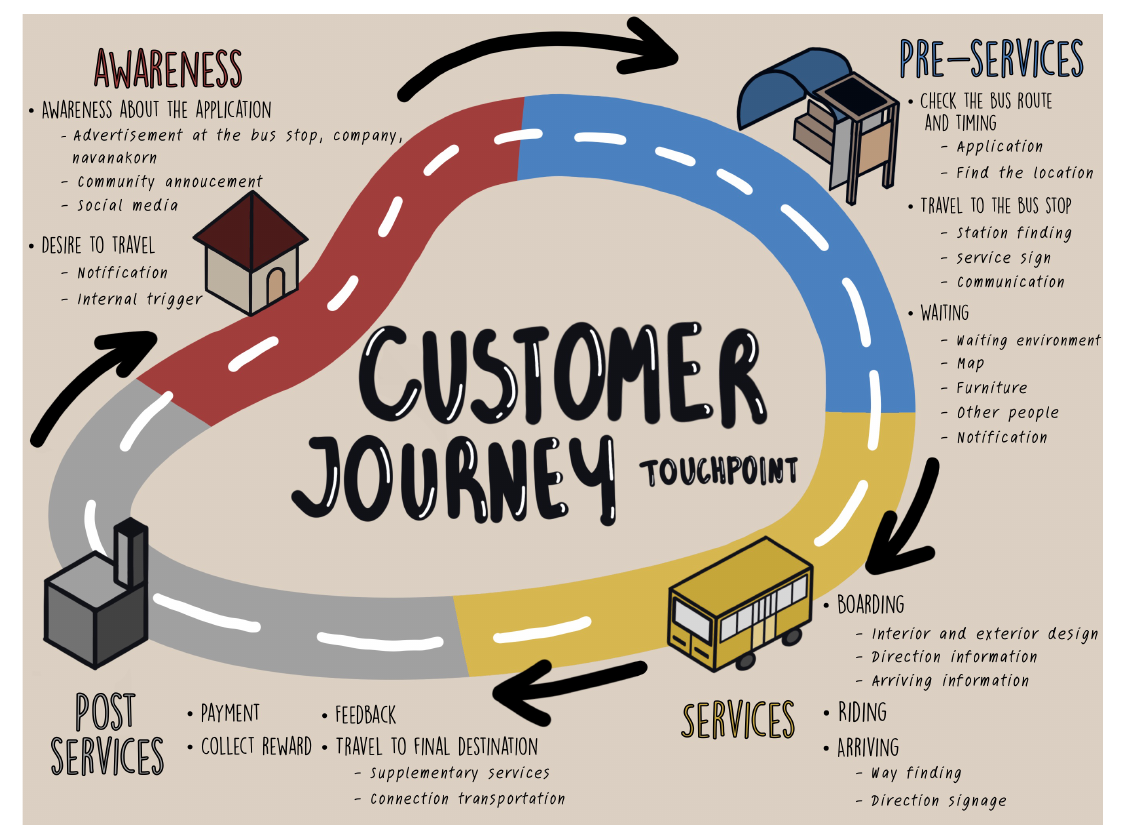
Figure 17. Theoretical development of Spin Bus app using the customer journey design principles that identify and assess each touch point to optimize the trip experience. Graphics credits to Theerawan Junditthawong, Sajin Vimolpitayarat, Sakdithat Sopon, DBT244